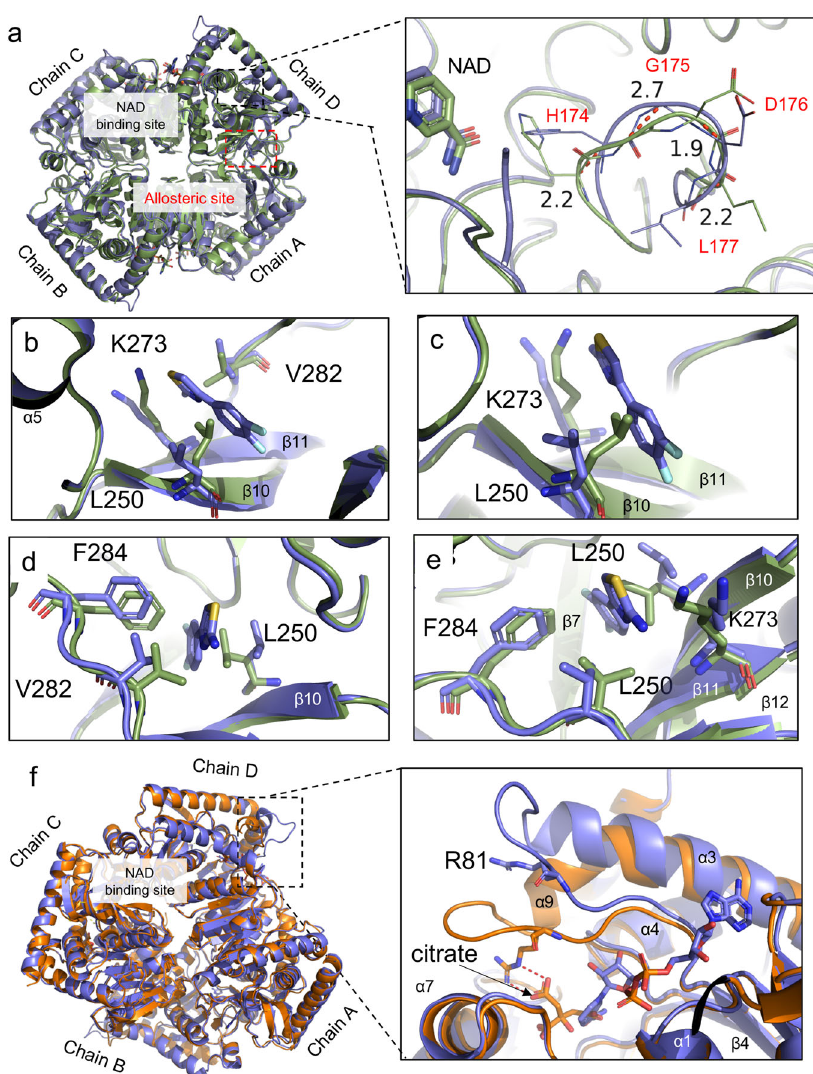
Fig. 3 Apo (green cartoons), citrate-liganded (orange cartoons, PDB ID:5NFR) 20 and 4DT bound (purple cartoons) structures of Pf MDH. a A close-up view of the active site loop in close proximity to the NAD binding site. Pairwise C α distances are expressed in Å and represented as red dotted lines while loop amino acids as lines. b – e Side chain rearrangements of the interface residues involved in the formation of 4DT binding site (sticks representations). f Close-up view displaying the lifting of the active site loop and distancing of R81 (stick representation) with consequent loss of one ionic interaction depicted as red dotted